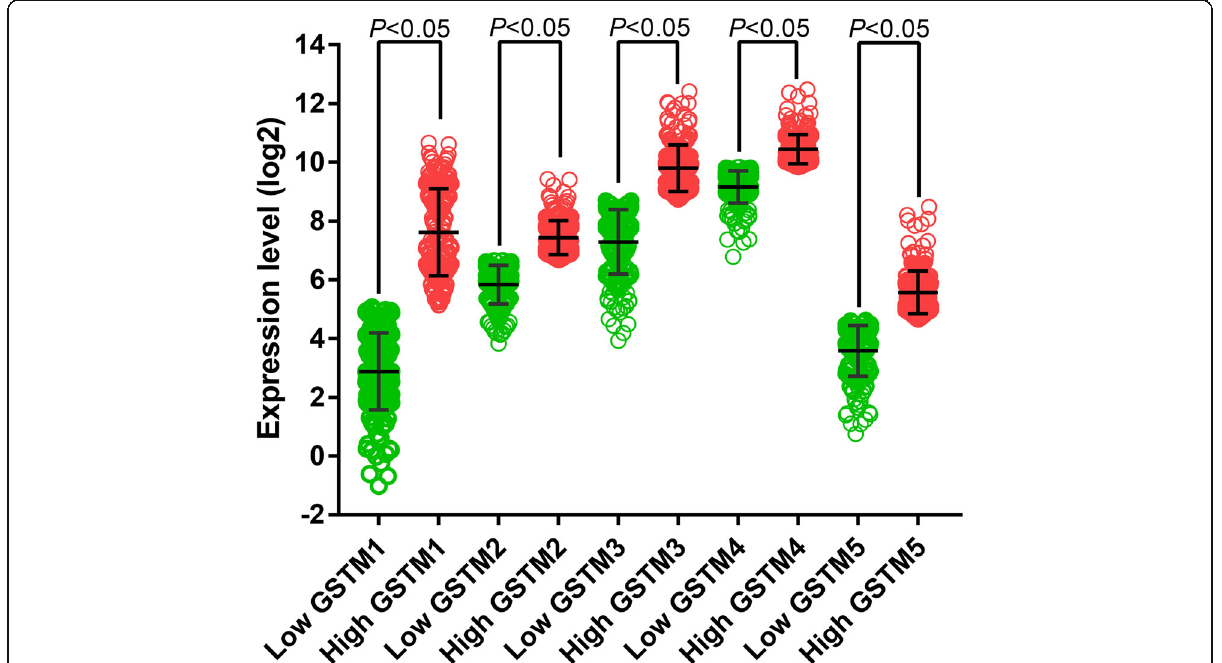
Fig. 3 Scatter plots for GSTM1, GSTM2, GSTM3, GSTM4, and GSTM5 gene expression levels in The Cancer Genome